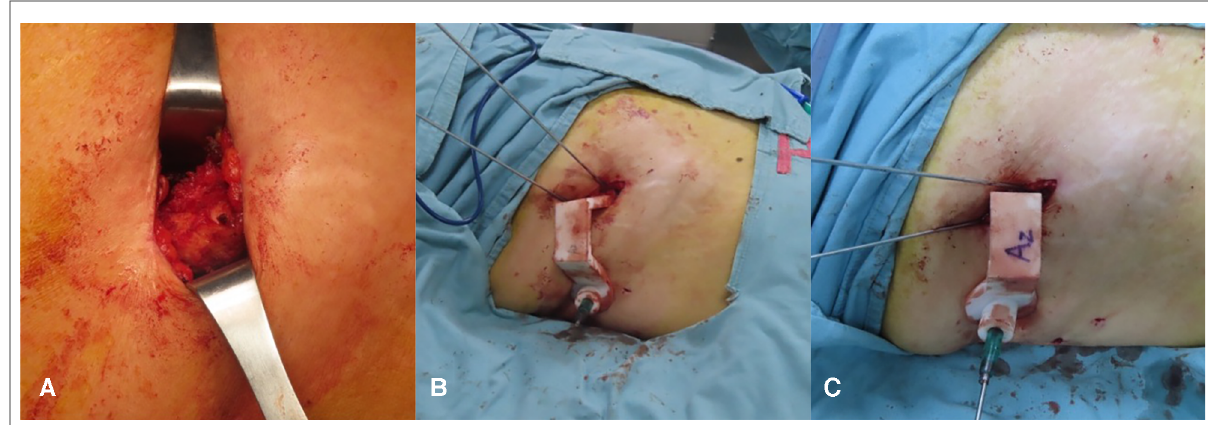
FIGURE 5 The processes in inserting guidewires with 3D printing guide template. ( A ) Make an incision on the body surface next to the anterior superior iliac spine. ( B,C ) Anchor the S1 and S2 screw guide templates at the iliac spine respectively and place the guidewires along the positioning hole.